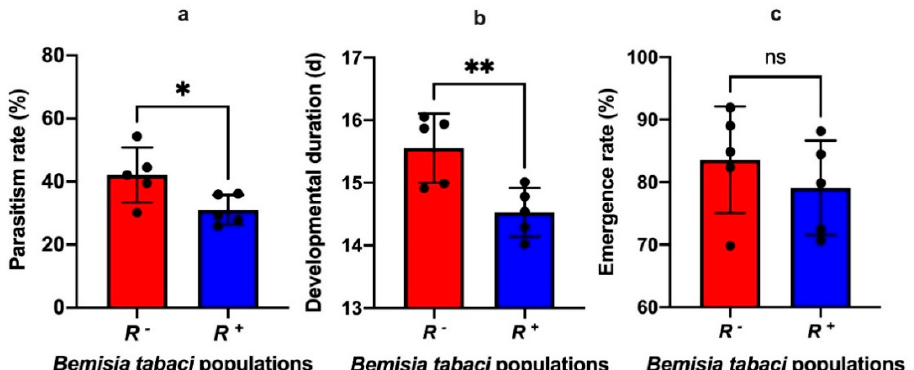
Figure 5. The effects of Rickettsia infection in B . tabaci MEAM1 on the parasitism of Encarsia formosa . ( a ) parasitism rate, ( b ) developmental duration of E . formosa F1 larvae, ( c ) emergence rate of E . for-mosa F1 adults. R + : Rickettsia positive population, R − : Rickettsia negative population. Data were com-pared among treatments using t -test, and stars over the bars *, ** indicate that differences were significantly different at 0.05 and 0.01 levels respectively, ns indicate that differences were not signifi- cant.